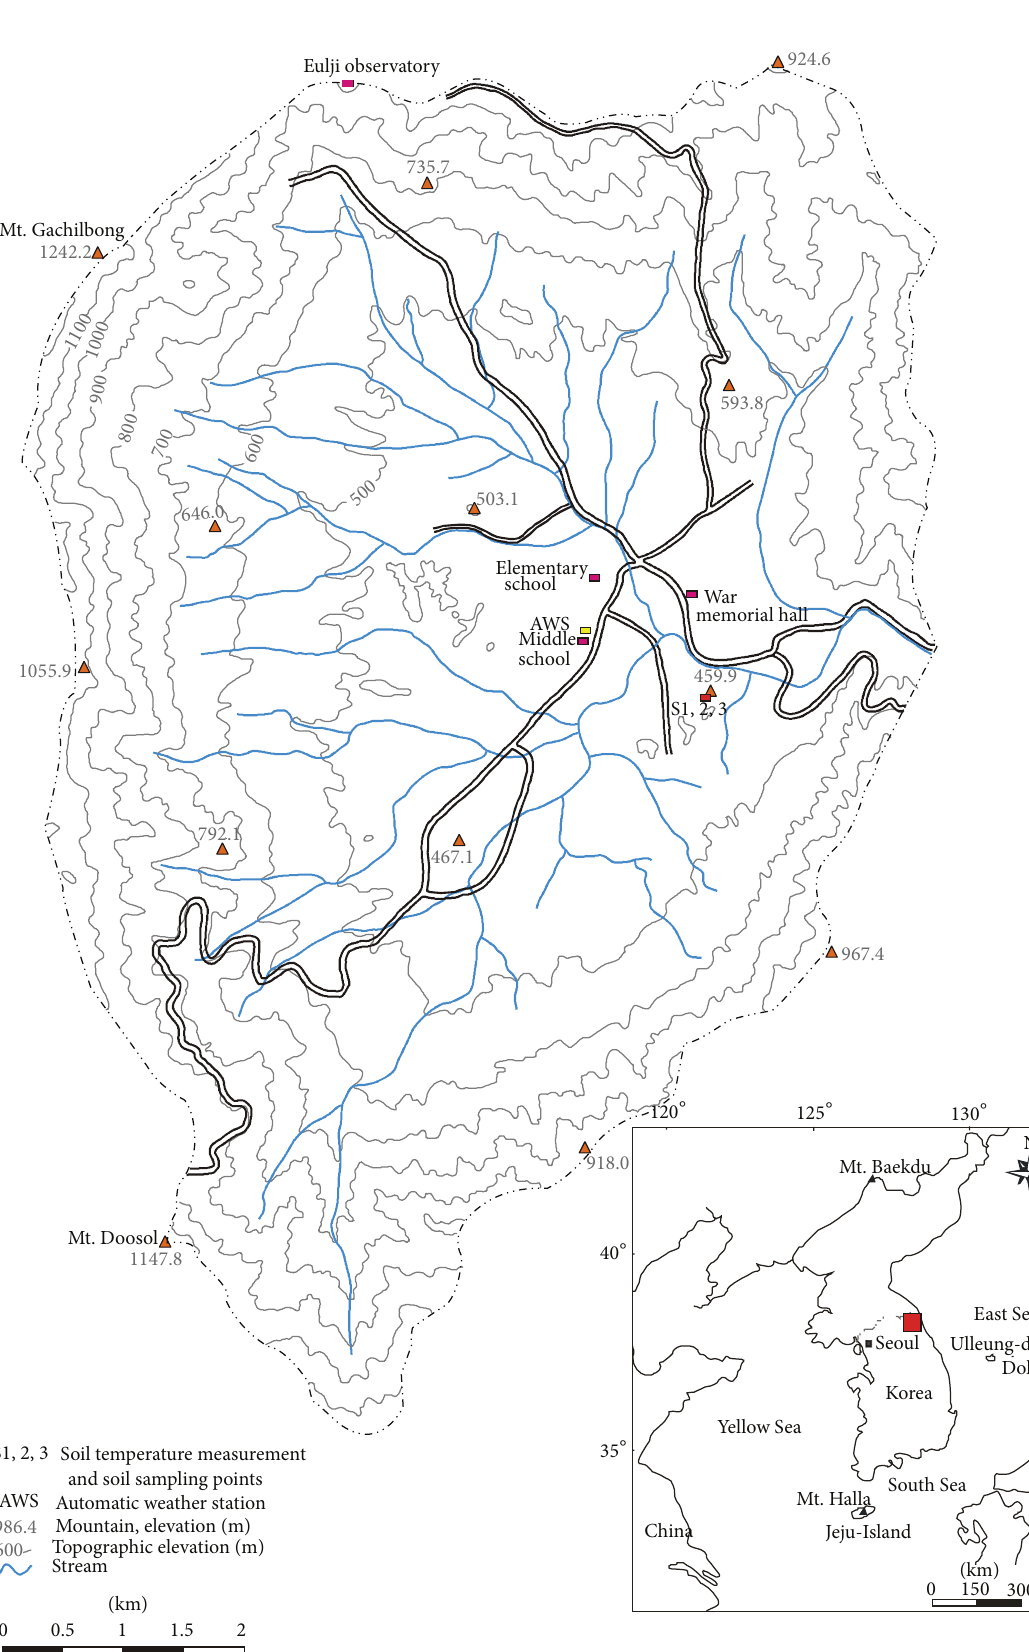
Figure 1: Location of the study